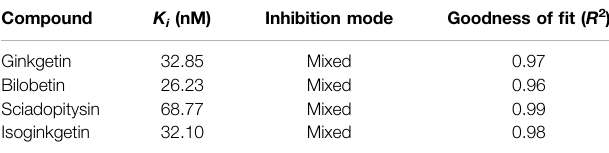
TABLE 3 | The inhibition parameters and inhibition modes on four bi fl avones isolated from Ginkgo biloba against CES2-catalyzed FD hydrolysis in HLMs. Compound